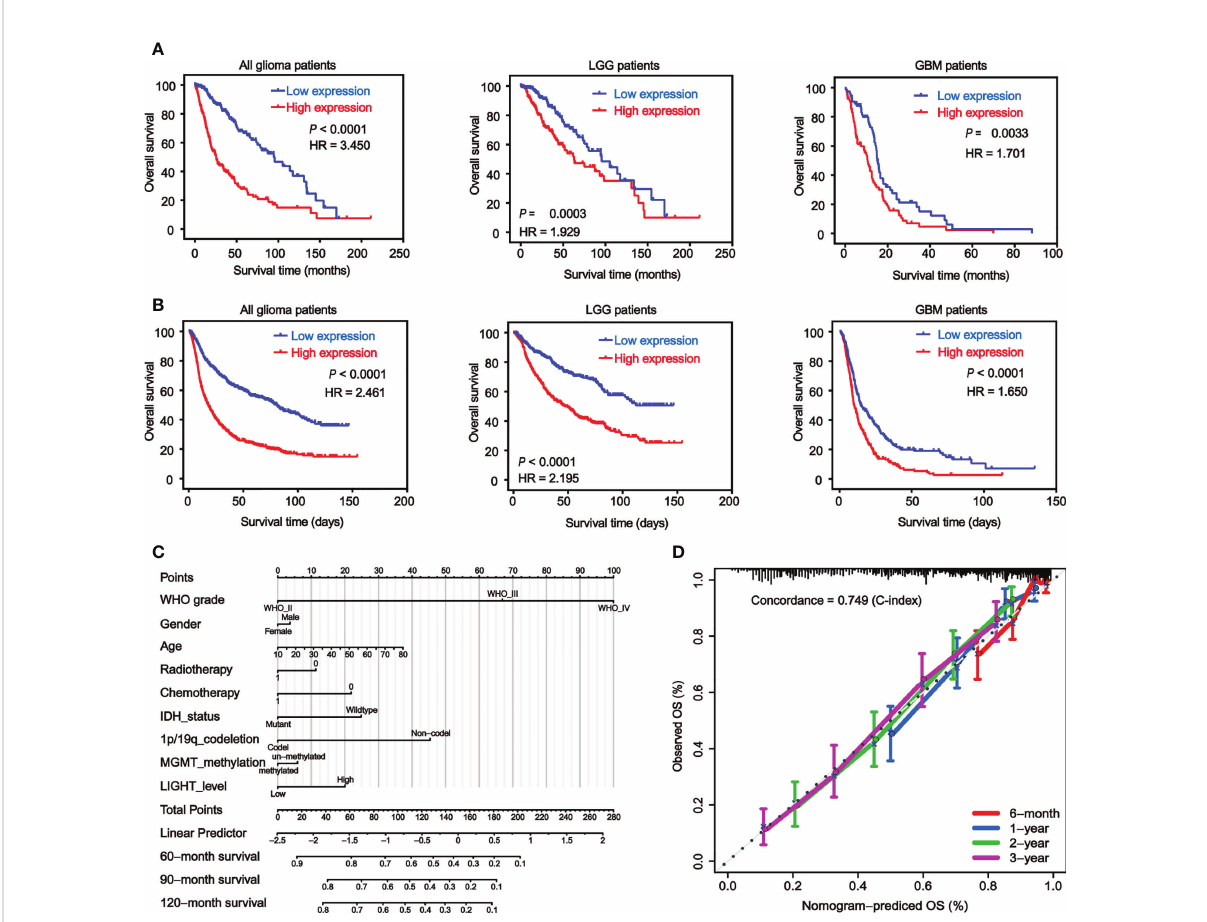
FIGURE 3 Elevated LIGHT expression predicts worse prognosis of GBM patients. Kaplan − Meier analysis of the overall survival (OS) rate of all glioma, LGG and GBM patients in the TCGA (A) and CGGA (B) datasets. (C) Nomogram predicting the proportion of glioma patients with OS. (D) Calibration plot showing the predicted and observed OS. The predictive performance of the model is compared to the perfect prediction, which is the diagonal